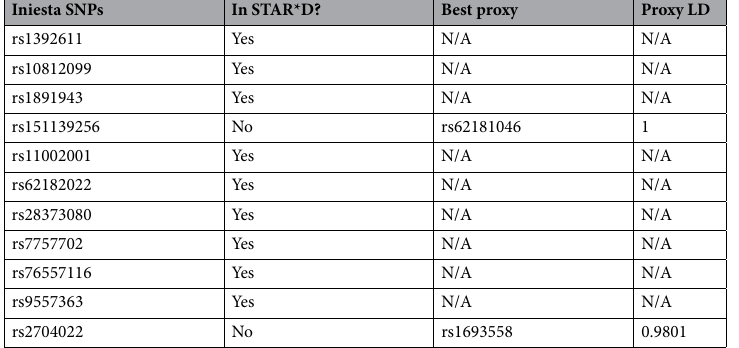
Table 1. A priori SNPs from 10 shown to predict escitalopram response and the corresponding SNPs used in the STAR*D sample. Proxy LD refers to R 2 between the Iniesta SNP and the proxy SNP, as calculated by LDlink 47 (https ://ldlin k.nci.nih.gov/). As the majority of the STAR*D sample is of European ancestry, we used the European populations in 1000 Genomes Project Phase 3 v5 as the reference